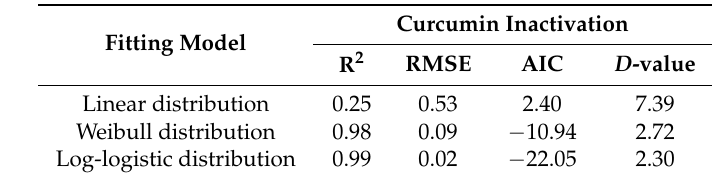
Figure 4. Data fitting of the inactivation curve for MNV under long-term incubation. MNV was mixed with 1 mg/mL of CCM and stored for 1, 3, 7 or 14 days at 4 °C. Data were fitted to several different models. Table 2. Comparison of linear, Weibull, and log-logistic models in terms of long-term anti-noroviral data for curcumin.